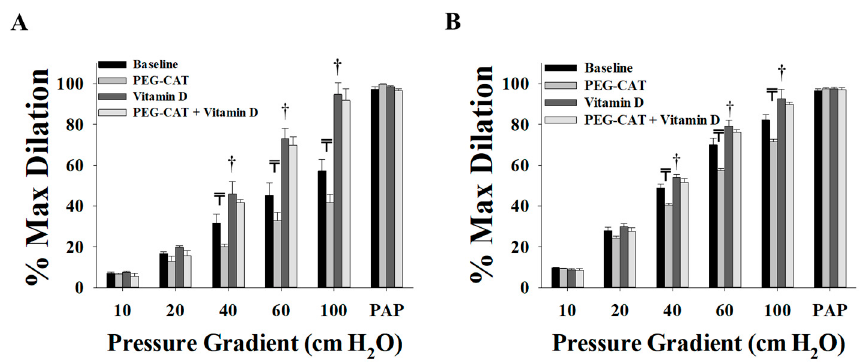
Figure 4. Effect of scavenging H 2 O 2 via PEG-CAT on FID in adipose tissue resistance arterioles collected on the day of surgery ( n = 15). FID measurements corresponding to intraluminal pressure gradients of 10 – 100 cm H 2 O in VAT arterioles ( A ) and SAT arterioles ( B ) with and without vitamin-D incubation. All measurements are presented as means ± standard error (SE); ₸ p < 0.05 comparing L-NAME with baseline, and † p < 0.05 comparing vitamin D with baseline.